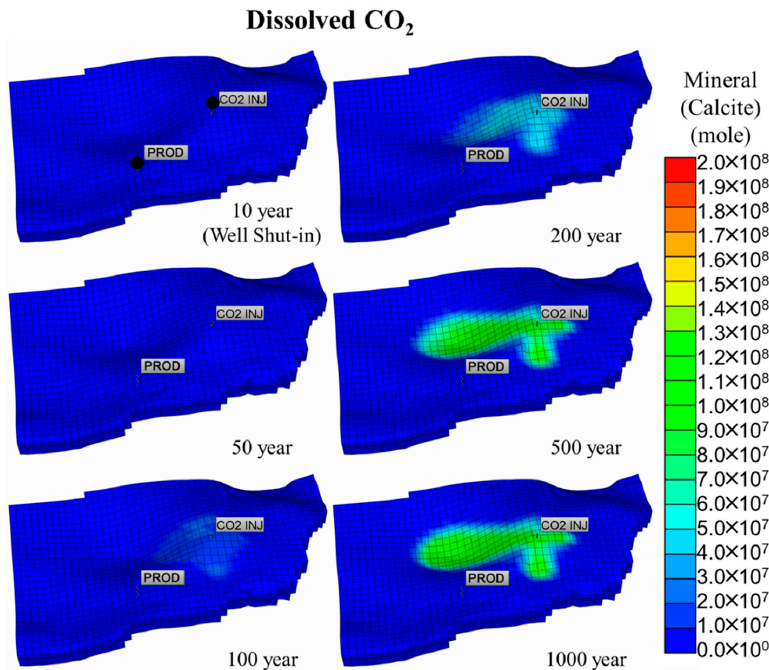
Figure 12. Spatial distribution of the change in moles of calcite in the dissolved CO 2 scenario.